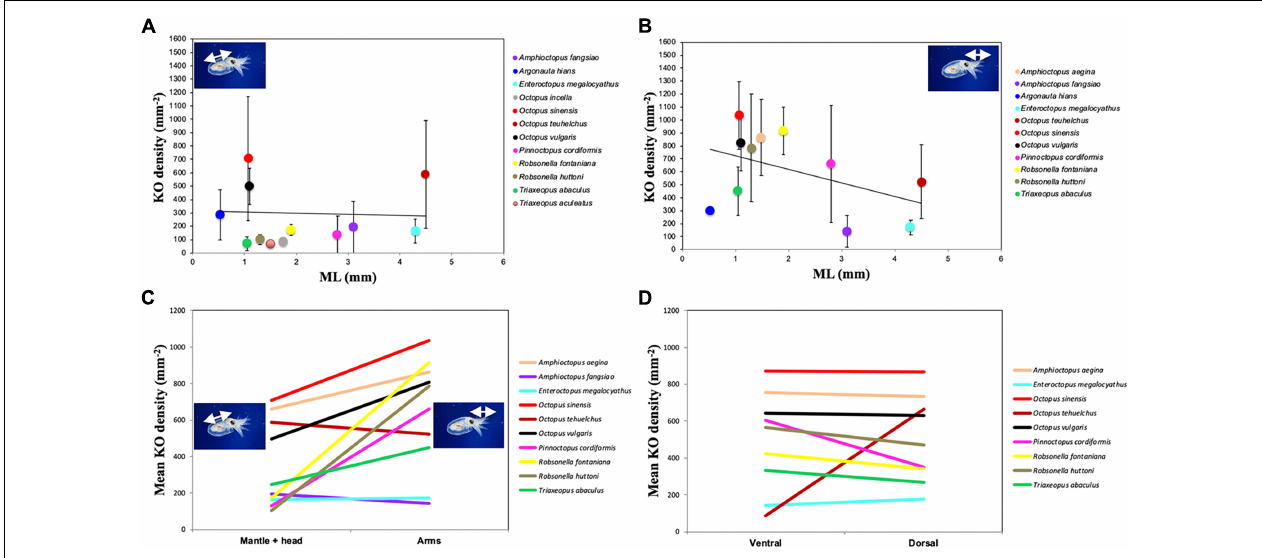
FIGURE 8 | Density of Kölliker’s organs (KO) over (A) mantle + head and (B) arms in octopod hatchlings (except O. sinensis , aged 12 days). Line indicates linear relationship, error bars indicate standard deviation; ML, mantle length. Mean KO densities are shown: (C) over mantle + head, and arms and (D) on the ventral and dorsal